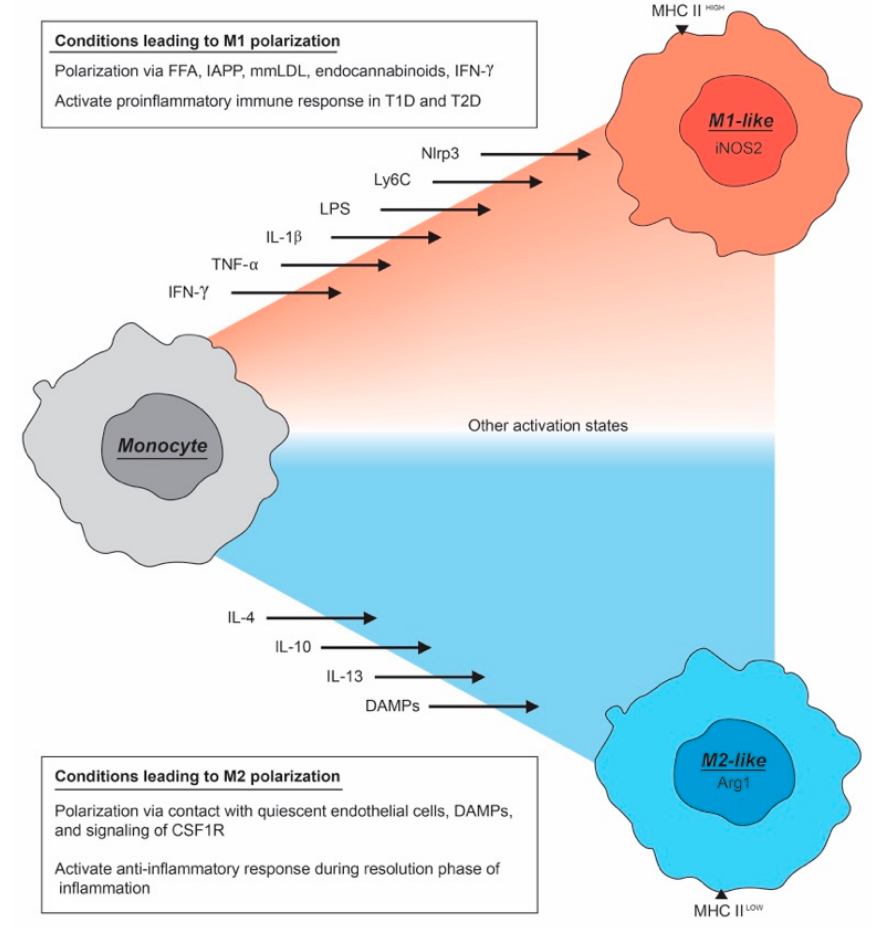
Figure 1. Polarization of monocytes to M1-like or M2-like macrophages. Macrophages can be polarized along an activation spectrum in response to di ff erent signals within their microenvironment. An undi ff erentiatedmacrophagewill leanmoreM1-like underproinflammatoryconditions,